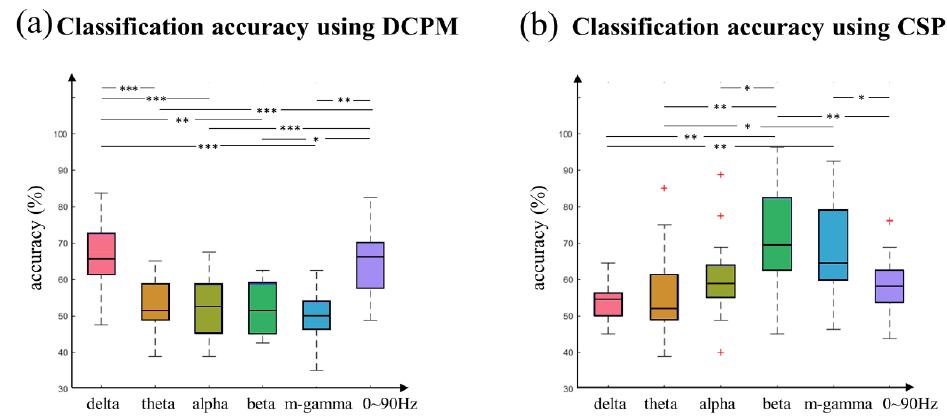
Figure 6. ( a ) DCPM; ( b ) CSP classification accuracy of delta, theta, alpha, beta, mid-gamma, and 0~90 frequency-band. Statistical significance: * 0.01 < p < 0.05; ** 0.001 < p < 0.01; *** p < 0.001.